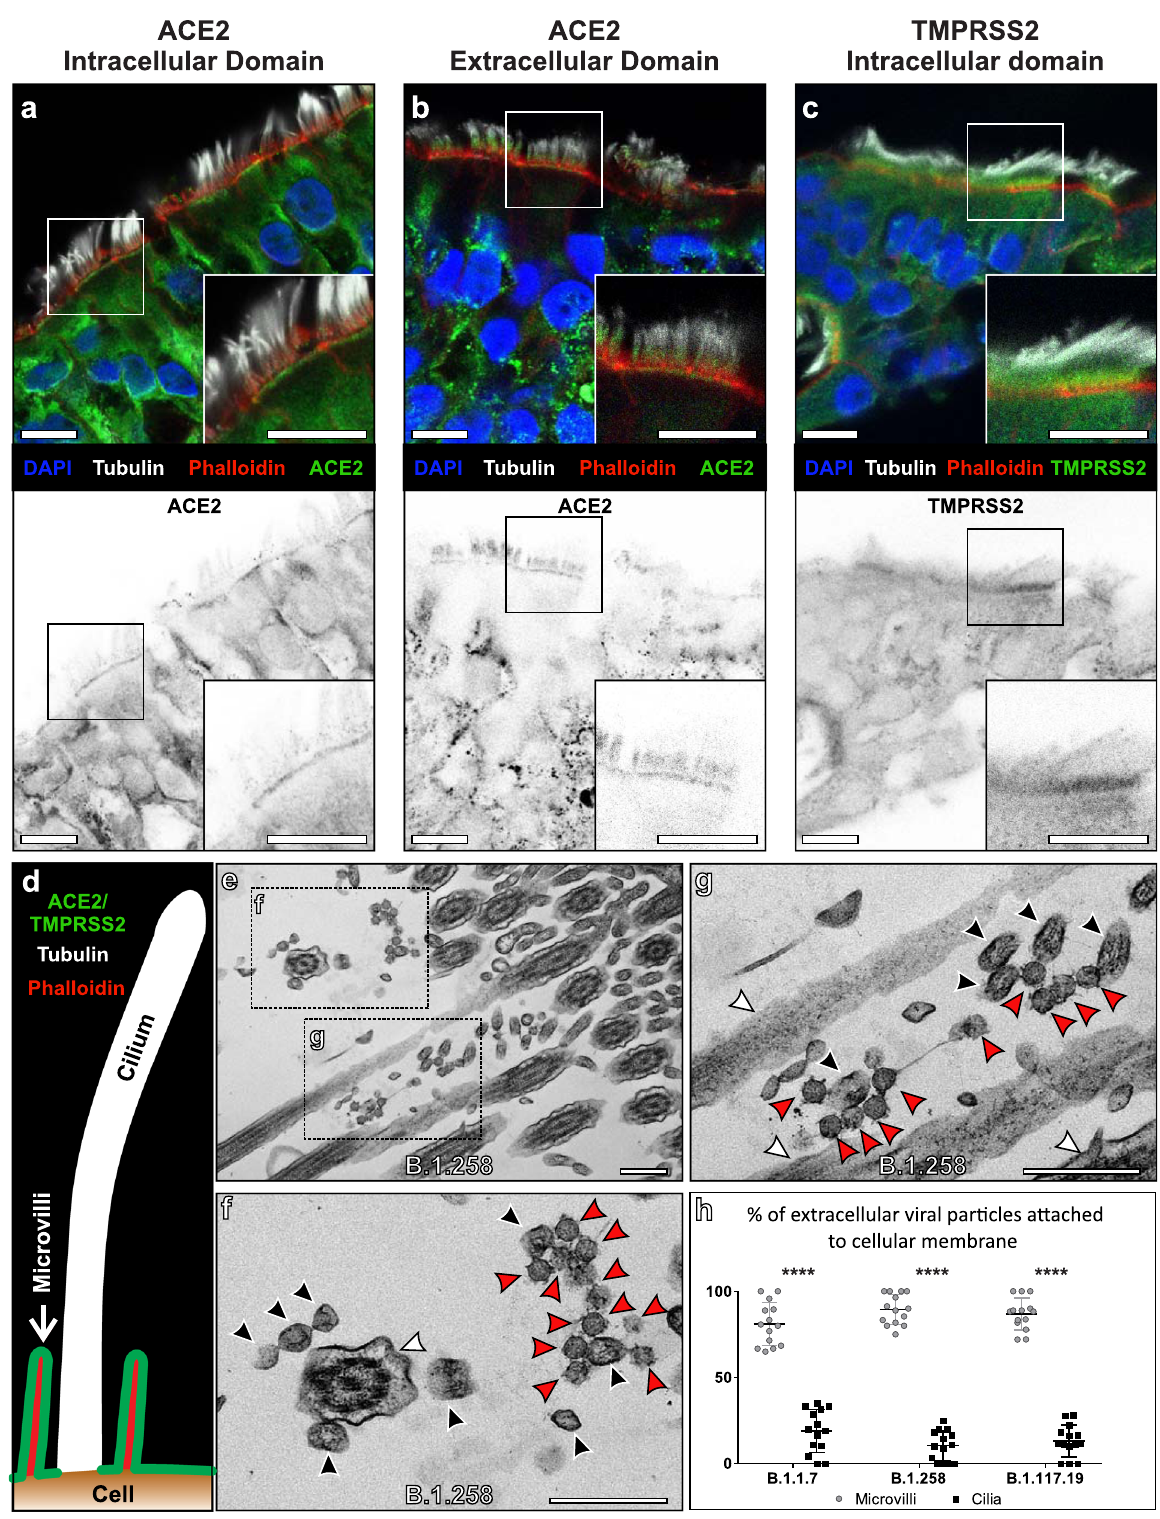
and the longer isoform of ACE2 at the microvilli base by the intracellular domain antibody would generate a stronger signal that is more readily detectable compared to the longer ACE2 isoform through the microvilli. A similar staining pattern was seen in a human nasal brushing biopsy showing that the protein localisation is not an artefact of cell culture (Supplementary Fig. 2). To validate the ACE2 and TMPRSS2 antibodies that